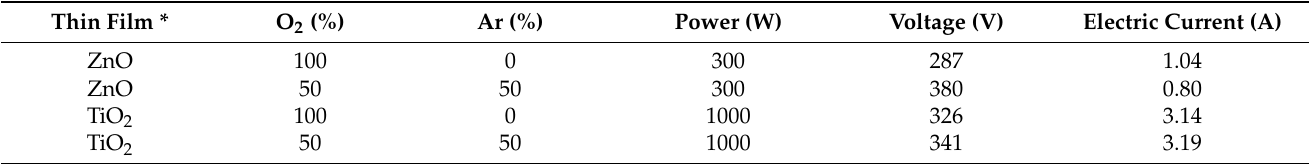
Table 1. Sputtering parameters used for the deposition of the ZnO and TiO 2 thin films onto ceramic- based supports with gold